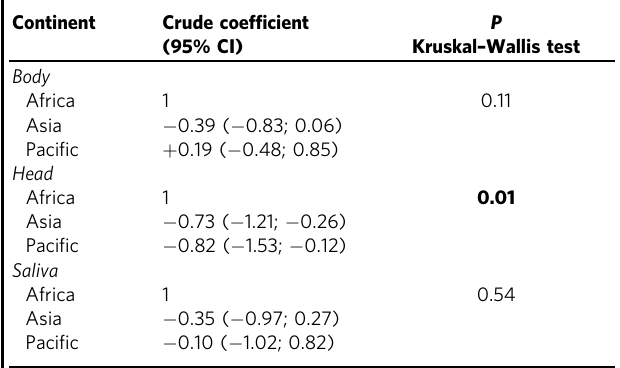
role of a YFV reservoir 36 alongside YFV-susceptible zoophilic mosquitoes 37 .